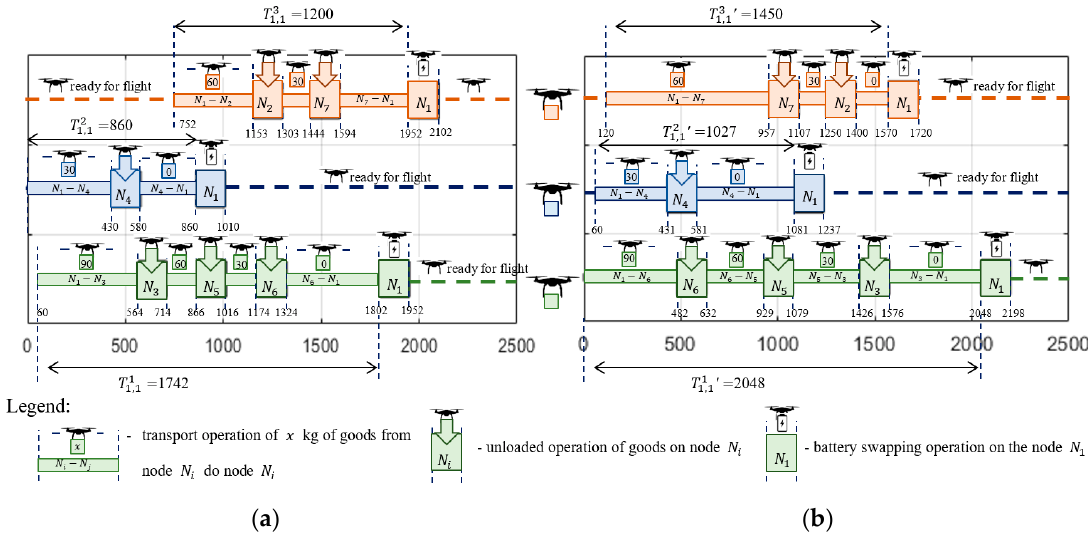
Figure 7. Obtained solution: ( a ) flight schedule for Strategy 1; ( b ) flight schedule for Strategy 2.